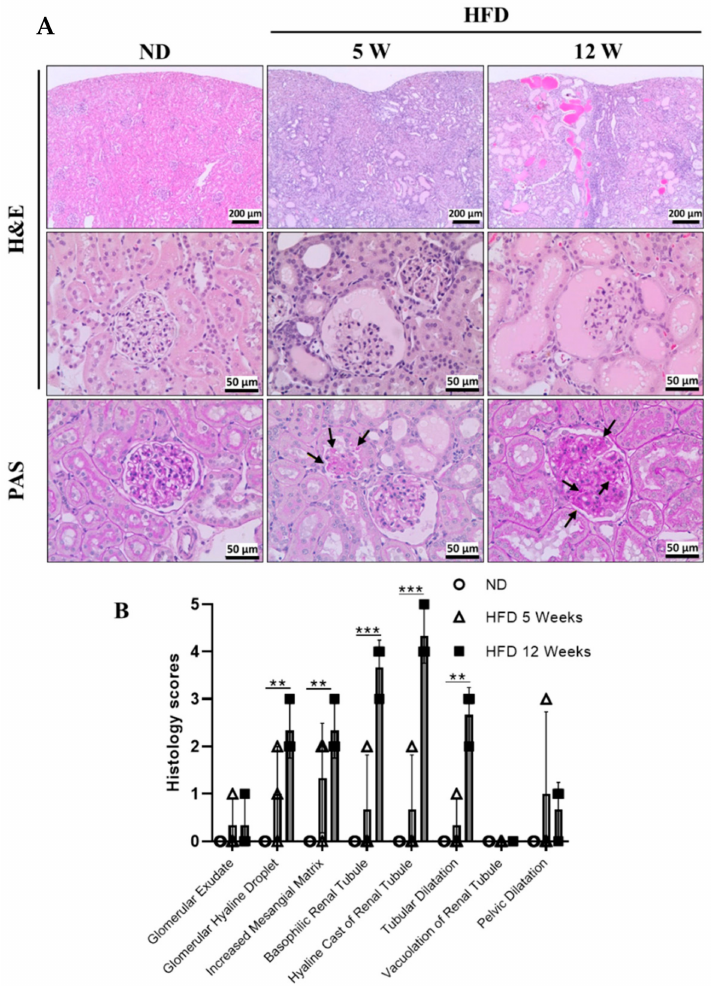
Figure 3. Kidney histology as diabetes progression. ( A ) Kidney samples were subjected to histology examination. Hematoxylin and eosin (H&E) and periodic acid-Schiff (PAS) staining analysis of renal histological abnormalities showing hyaline cast of renal tubules, mesangial cell expansion, thickening of the basement membrane, increased mesangial matrix, formation of glomerular hyaline droplet, and accumulation of PAS positive glycogen (black arrow) stores in kidneys. ( B ) Histology scores for the renal injury were shown. Scores (0, normal; 1, minimal; 2, slight; 3, moderate; 4, marked; 5, severe), ND, normal diet; HFD, high-fat diet; 5 W, 5 weeks; 12 W, 12 weeks. ** p < 0.01, *** p <